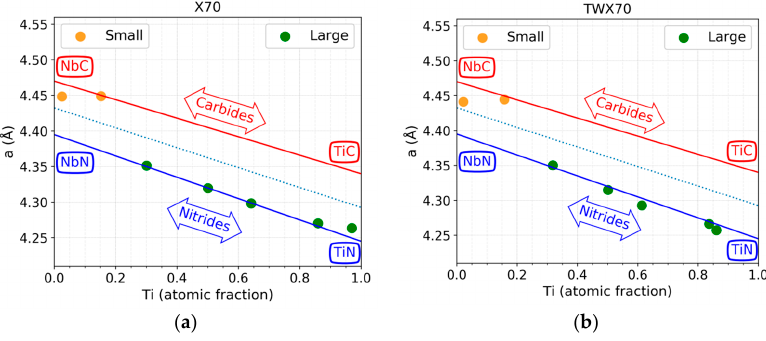
Figure 10. Lattice parameter as a function of Ti content for ( a ) X70 steel and ( b ) TWX70 steel.